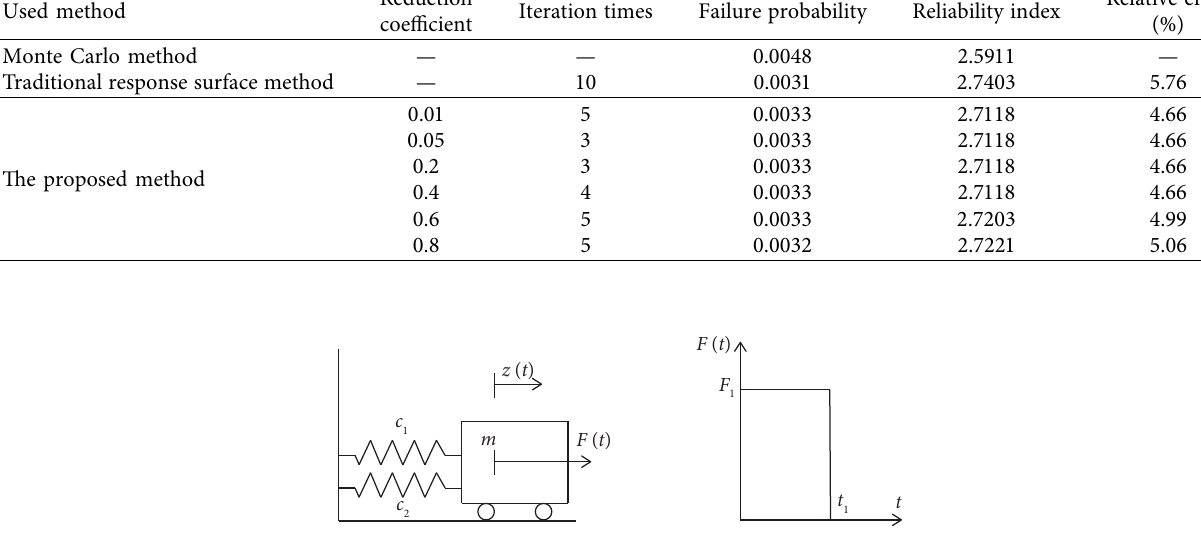
Figure 7: A nonlinear undamped single-degree-of-freedom structure. Table 7: Random variable distribution of example